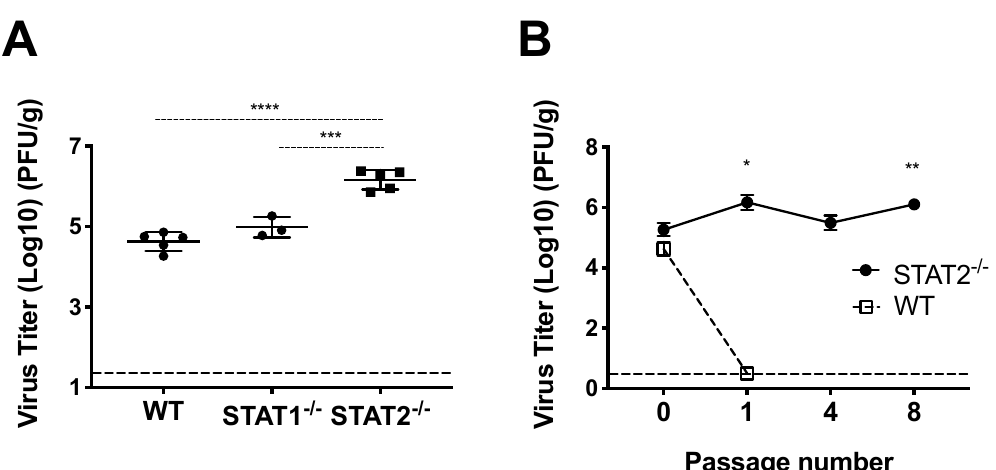
Figure 1. HMPV infection of and STAT2 − / − mice. ( A ) Mice were infected with HMPV TN / 94-49 and euthanized at day five of infection. Lung virus titers were determined by plaque assay. ( B ) HMPV TN / 94-49 was serially passaged in STAT2 − / − mice, and virus titers were measured from lung homogenate at day five of infection for various passages by plaque assay. *** p < 0.001, **** p < 0.0001, One-way ANOVA with Tukey post-hoc test. For ( B ), * p < 0.05, ** p < 0.01 compared to STAT2 − / − P0, One-way ANOVA with Tukey post-hoc test. Data are representative of two independent experiments in A. Data from B are from one experiment, n = 3–5 mice / group or